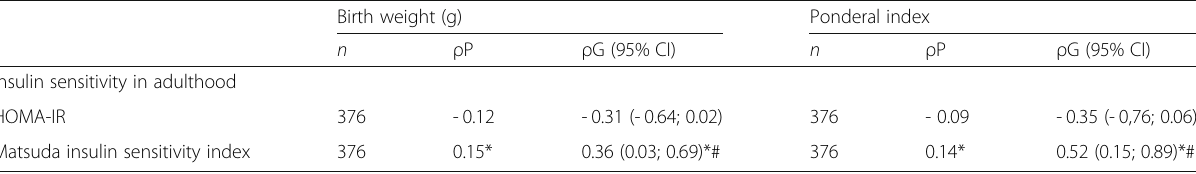
Table 4 Correlations between measures of birth body composition and adult measures of insulin